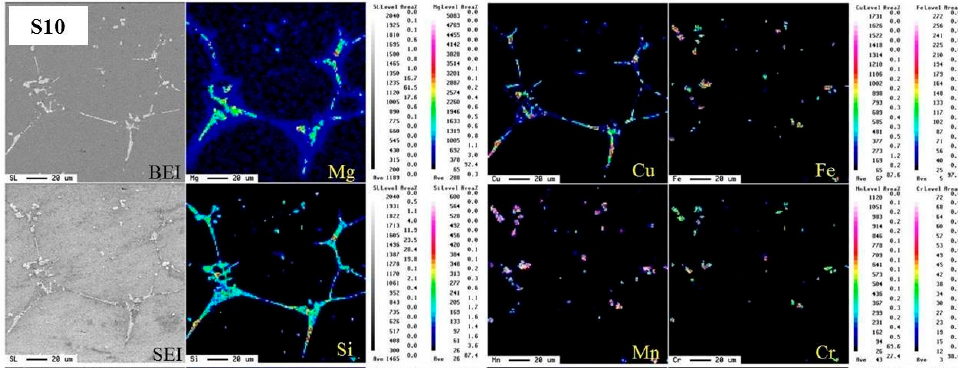
Figure 5. Elemental distribution of TS ‐ SIMA alloy (S10) obtained using EPMA.